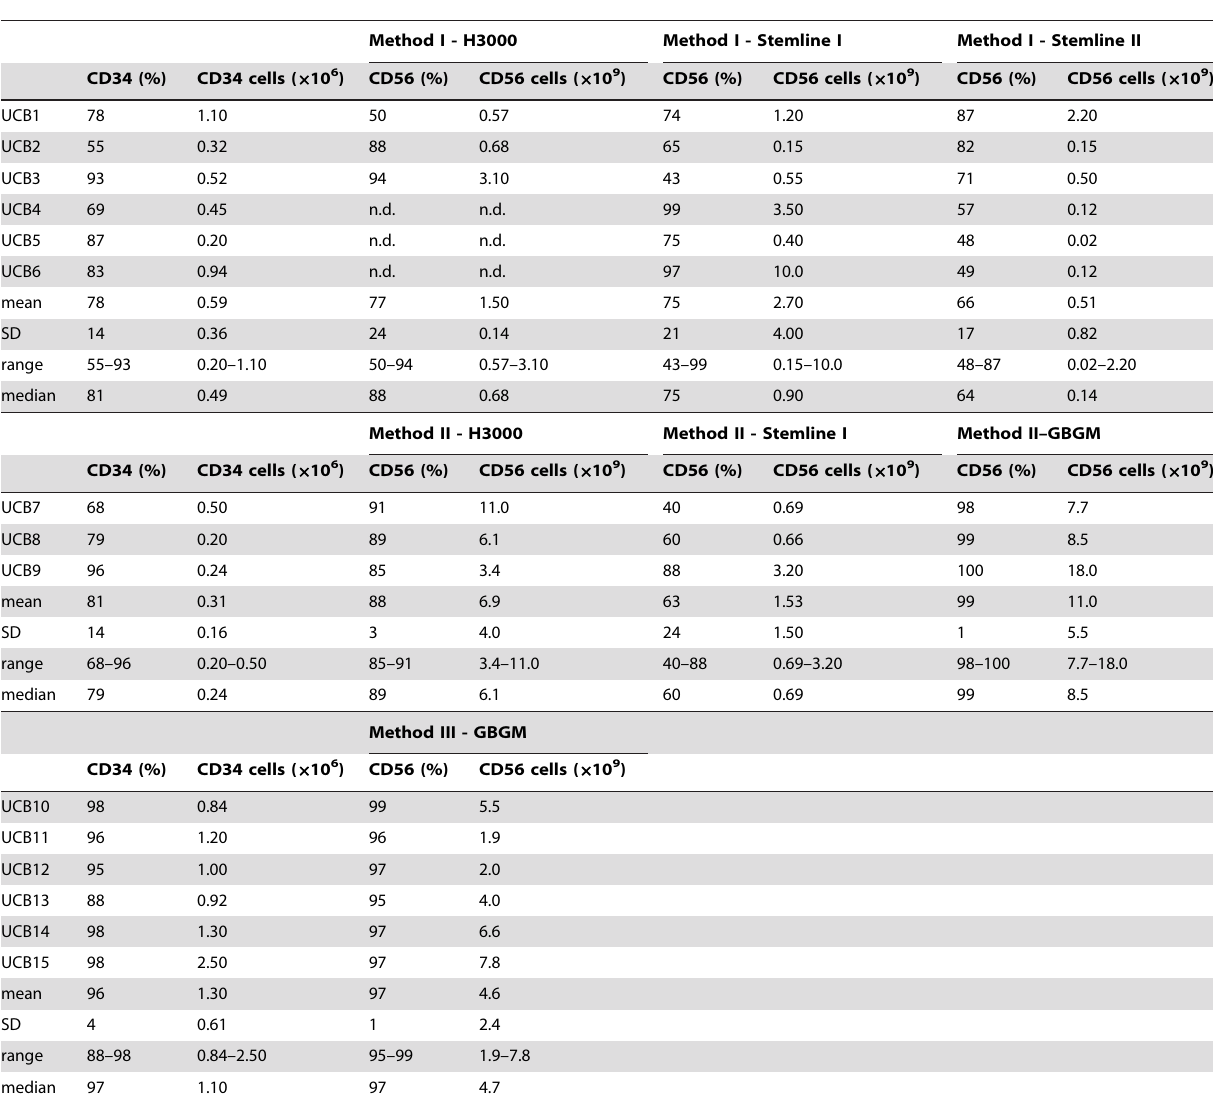
Table 2. Overview of CD34 + cell selections and NK cell culturing